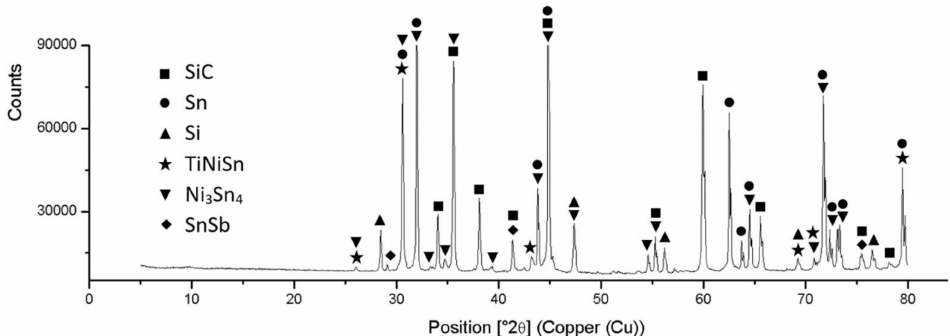
Figure 23. XRD analysis of boundary in SiC/SnSb5Ti3